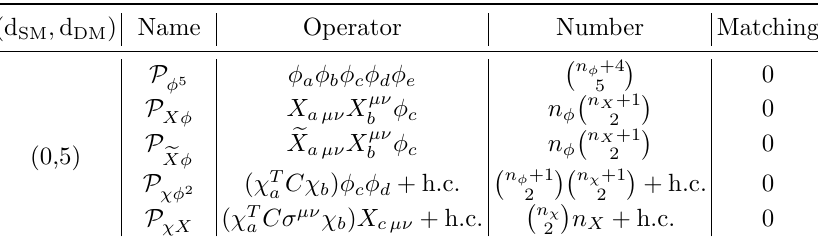
Table 6 . Dimension-five purely DM operators present in DSMEFT and DLEFT. The first column gives the dimensions of the SM and DM part of the operator, the fourth column is the number of operators, and the fifth column is the additional matching contribution at the EW scale.